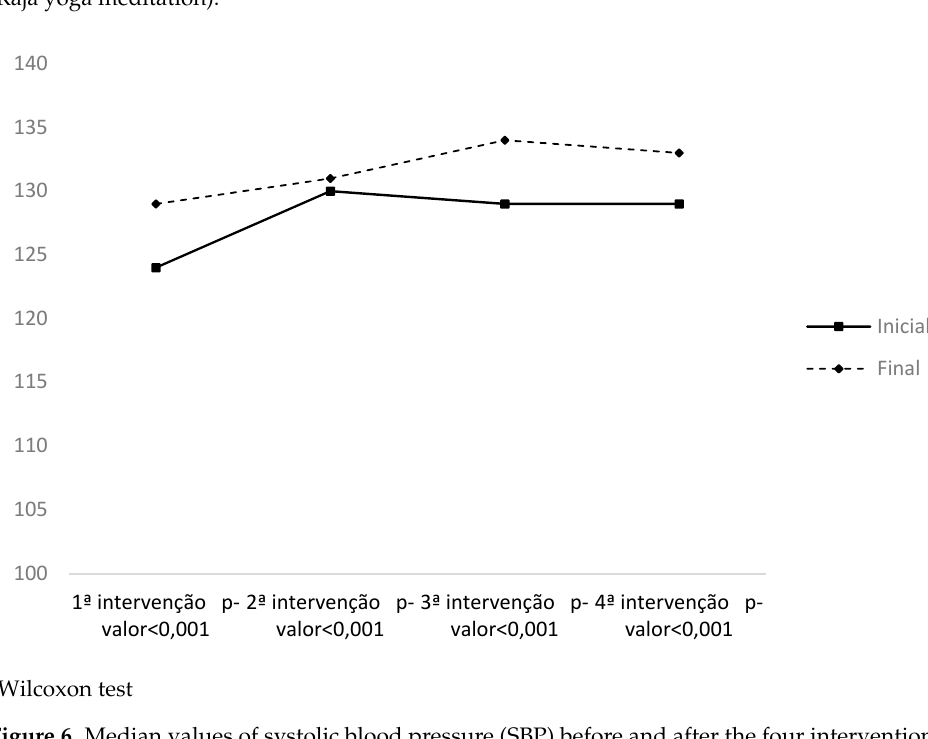
Figure 5. Median values of pulse oximetry (SPO2) before and after the four interventions in the IG (Raja yoga meditation).